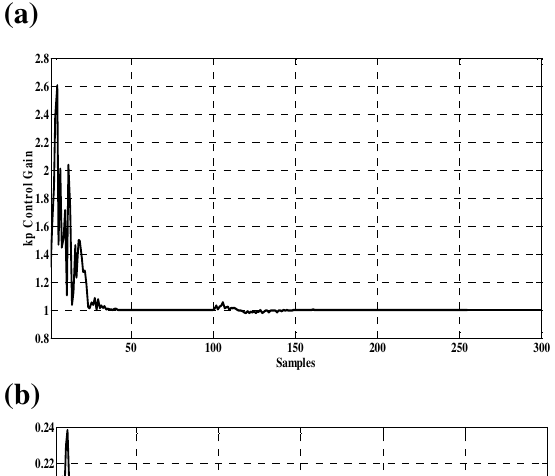
Fig. 11. On-line performance index (MSE) with disturbance effect. Fig. 12. Simulation results of the control parameters: (a) kp; (b) ki; (c) kd; (d)